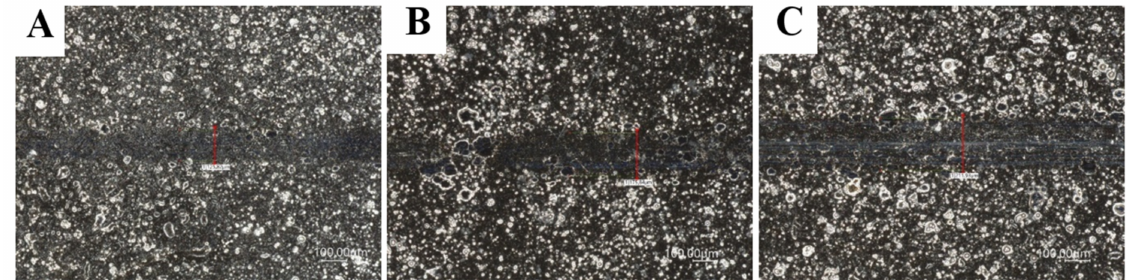
Figure 7. Images of scratches for samples with NiP/Si 3 N 4 coatings deposited in a bath with 2 g/dm 3 Si 3 N 4 (load: ( A ) 5 N; ( B ) 10 N; ( C ) 15 N; magnification: 500 × ).